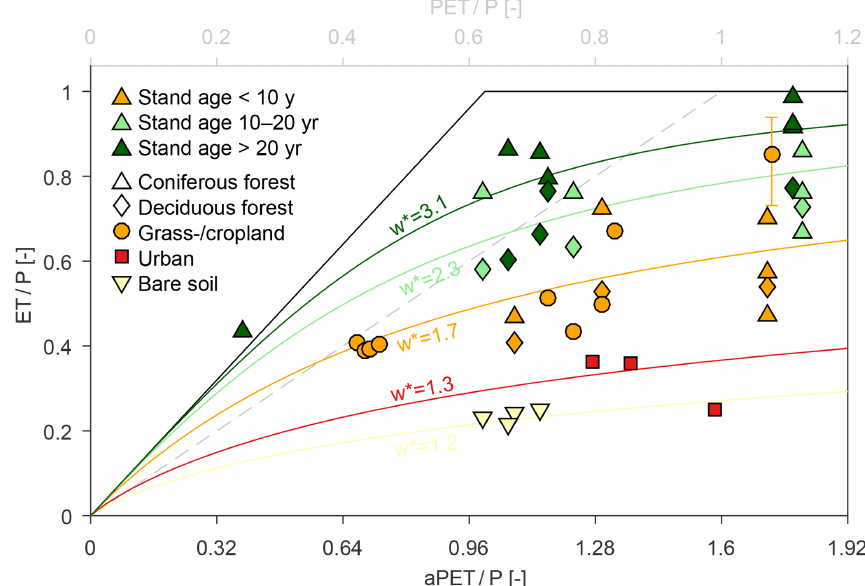
Figure 1. Climate and land use controls on water balance partitioning from long-term flux observations. See Table 1 for origin of data points. The error bar indicates the total spread over multiple lysimeters at the Brandis site with different soil types (Haferkorn and Knappe, 2002). Curves are based on Eq. (3). Note that symbol shape indicates land cover, but colours indicate stand age in the case of forest. The dashed grey line indicates the energy limit for non-adjusted